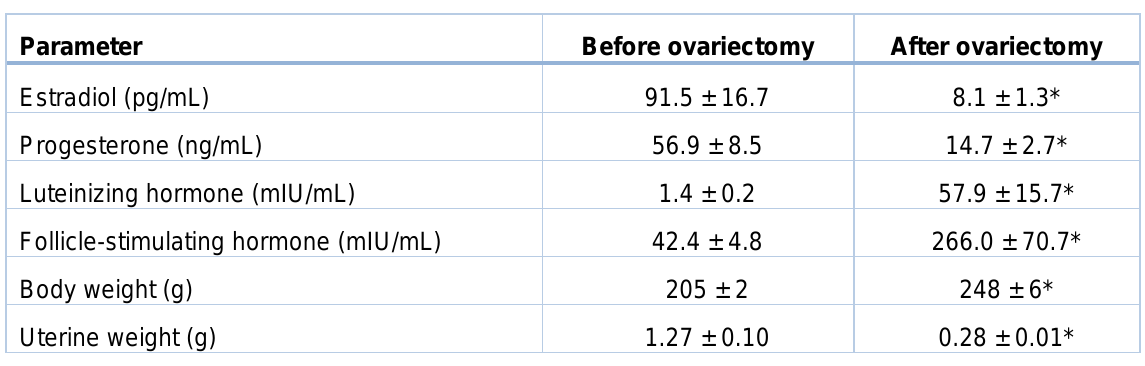
Table 2: Verification of ovariectomy in rats Parameter Before ovariectomy After ovariectomy Estradiol (pg/mL) Progesterone (ng/mL) Luteinizing hormone (mIU/mL) Follicle-stimulating hormone (mIU/mL) Body weight (g)